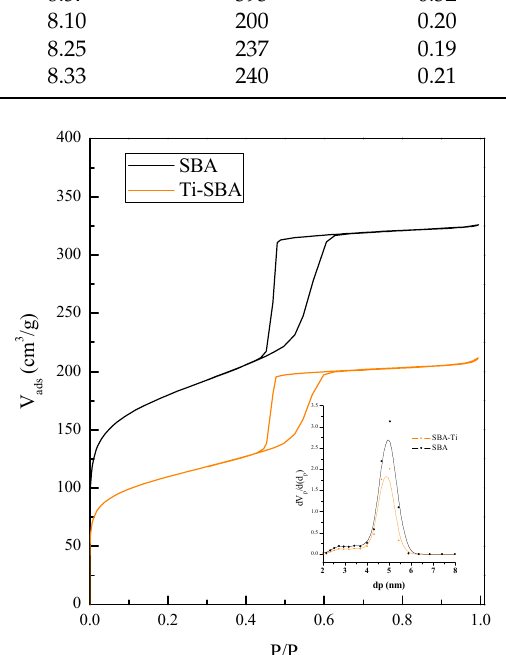
Table 1. Structural and textural properties of the support and as-prepared samples. Sample